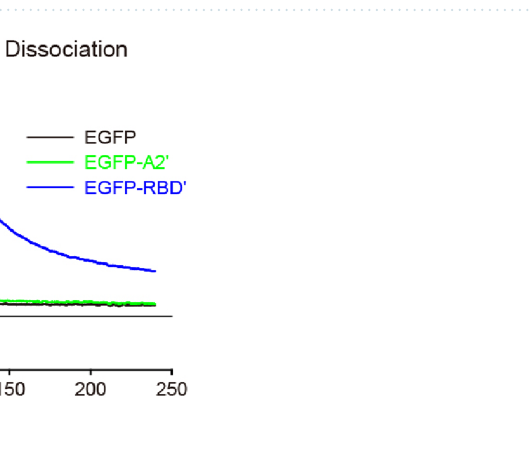
Figure 2. Characterization of SV2C-LD-binding affinity of the recombinant peptides using the GST-pull- down assay. ( a ) Schematic representation of the pull-down assay and the expected status of the resins after the assay. ( b ) Schematic illustration and gel image of the neuro-recognizable recombinant peptides (EGFP, EGFP-A2, EGFP-A2 ʹ , EGFP-RBD, and EGFP-RBD ʹ ) in the SDS-PAGE, obtained after the pull-down assay (M, marker peptide; arrows, except a pink arrow, indicate the target neuro-recognizable peptides). ( c ) Relative amounts of the target neuro-recognizable peptides measured using the ImageJ processing with the gel images, based on the concept that the amount of EGFP-RBD ʹ is 1. Data with different letters a ‒ c in the plot represent significant differences according to the Tukey’s test ( n = 3; average ± s.d.; P < 0.05). Original gels are presented in Supplementary Fig. S1.